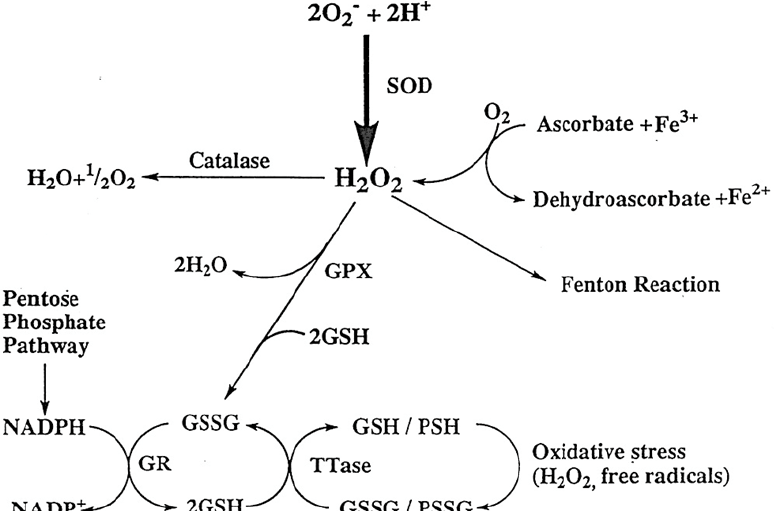
Figure 2. The reactive oxygen species and the antioxidant systems in the lens. H 2 O 2 - generated by the dismutation of superoxide anion or by the reaction between ascorbate and Fe 3+ can be degraded by several pathways. These include Catalase, glutathione peroxidase and the Fenton reaction. The decrease in the SH/S-S ration by oxidation can be reversed by the glutathione reductase (GR)- pentose phosphate shunt cycle and by thioltransferase (TTase). These mechanisms protect the lens from oxidative damage. GR: glutathione reductase; GPx: glutathione peroxidase; SOD: superoxide dismuase; TTase: thioltransferase. Reprinted with permission from Lou, PRER (2003); Copyright Elsevier 2003